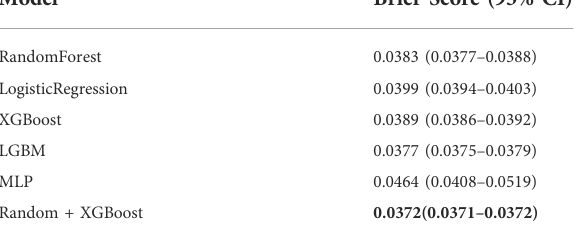
TABLE 4 Calibration of classi fi cation models including selected